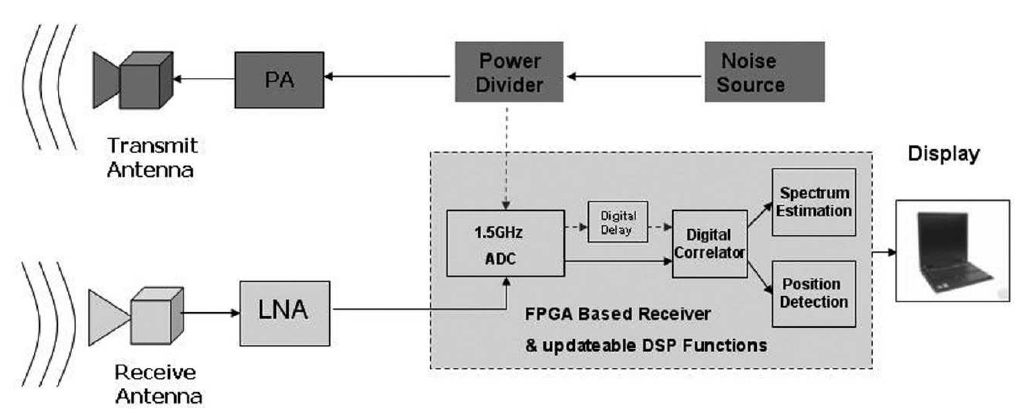
Figure 16. A schematic of a digital random noise UWB radar sensor